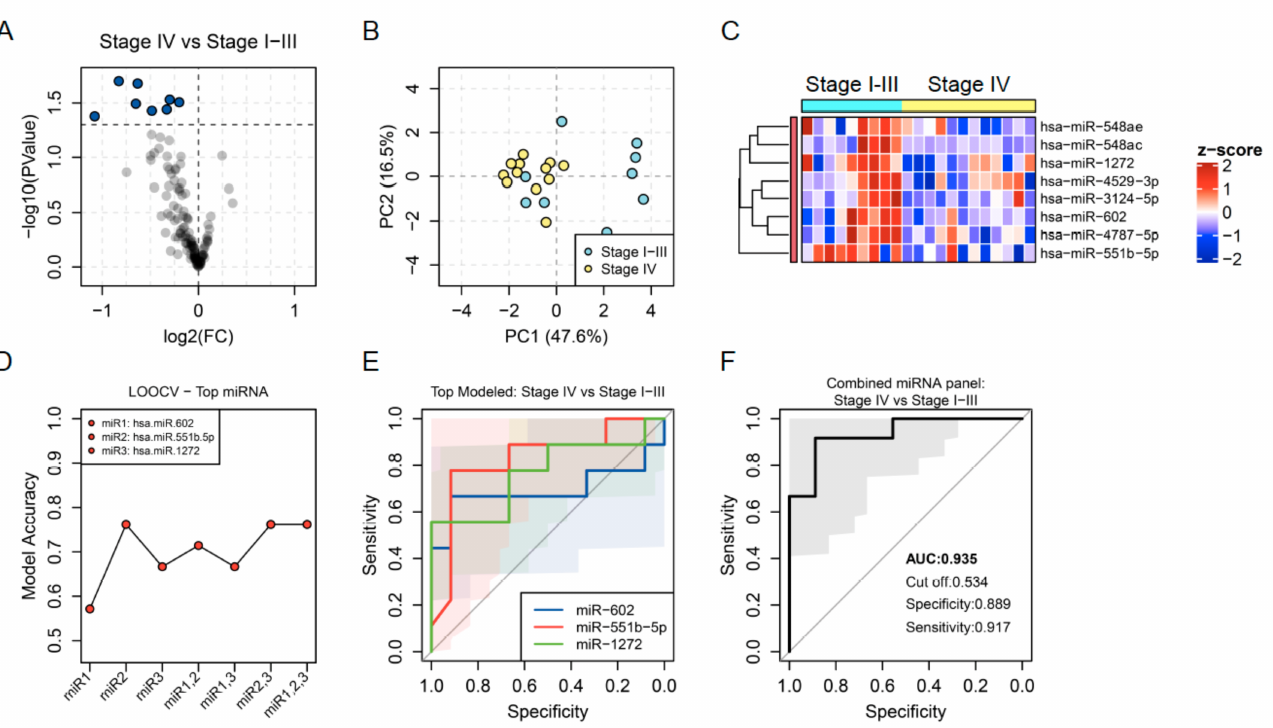
Figure 4. ( A ) Volcano plot showing fold change (FC) and statistical significance of individual miRNA levels in the breath condensate of lung cancer patients with stage IV compared to stage I-III. Blue dots represent negatively regulated miRNAs ( p < 0.05). ( B ) Regulated miRNAs calculated PCA plots showing the PC1 and PC2 scores for individual lung cancer patients with stage IV (yellow dots) and stage I-III (blue dots). ( C ) Heatmap showing z-score of miRNAs regulated in EBC from lung cancer patients with stage I-III and stage IV. ( D ) Accuracy of stage prediction calculated by LOOCV models for individual miRNAs and for the four possible combinations. ( E , F ) ROC curves predicted for an individual ( E ) and combined miRNAs ( F ) selected through a random forest iteration